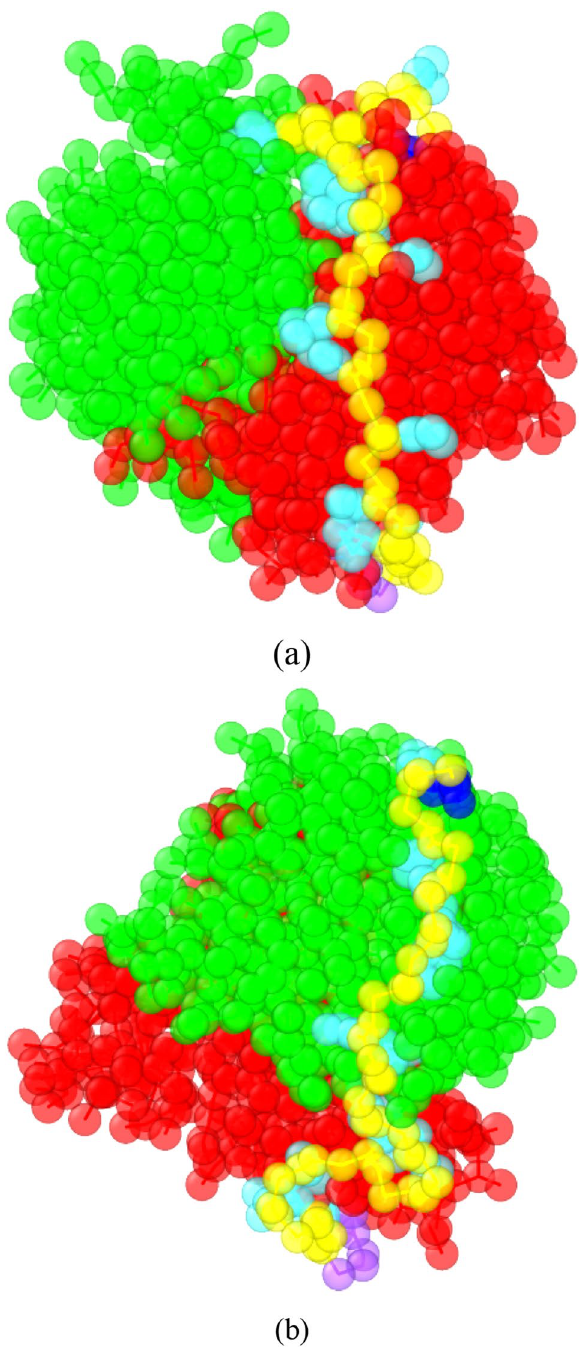
Figure 3. The CG Apt EpA /EpCAM complex structures with the two lowest binding energies after the STUN- BH-DMD search for ( a ) CG_Case 1 and ( b ) CG_Case2. The Apt EpA /EpCAM binding energies of CG_Case1 and CG_Case2 are about − 1837.8 kJ/mol and − 1675.1 kJ/mol, respectively. The Apt EpA backbone and nucleobase are shown in yellow and cyan, while the 5 ′ and 3 ′ beads are colored in dark blue and purple. The molecules of the EpCAM dimer are coloured in green and red, respectively. For clarity, all water beads, antifreeze beads, and ionic Na+ beads are